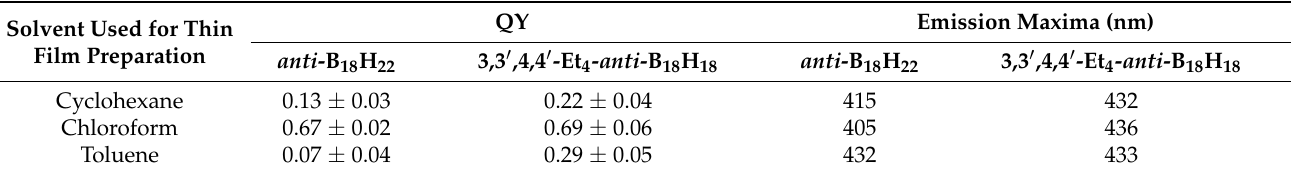
Table 4. QY of borane compounds in a polystyrene matrix in the form of thin film cast from various solvents. QY Emission Maxima (nm) Solvent Used for Thin Film Preparation Chloroform